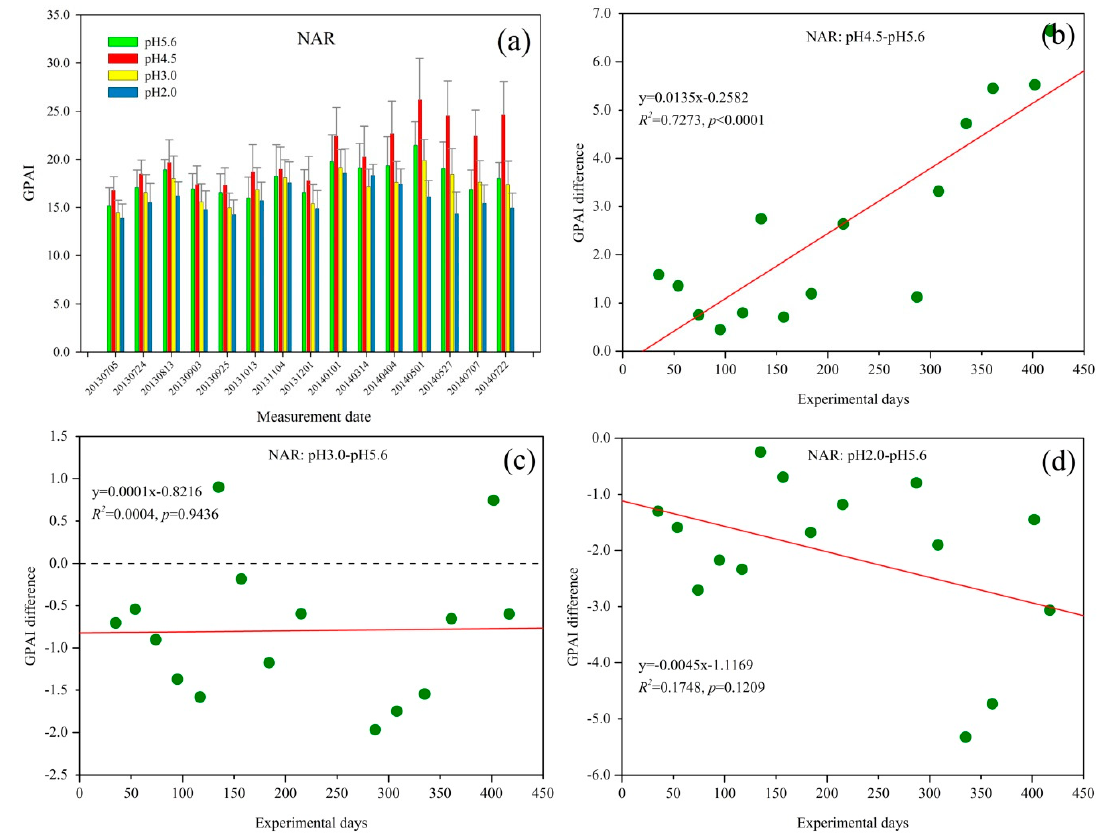
Figure 4. ( a ) Green peak area index (GPAI) trend of Q. glauca under nitric acid rain (NAR) treatment; and ( b – d ) the GPAI difference between different stress levels of